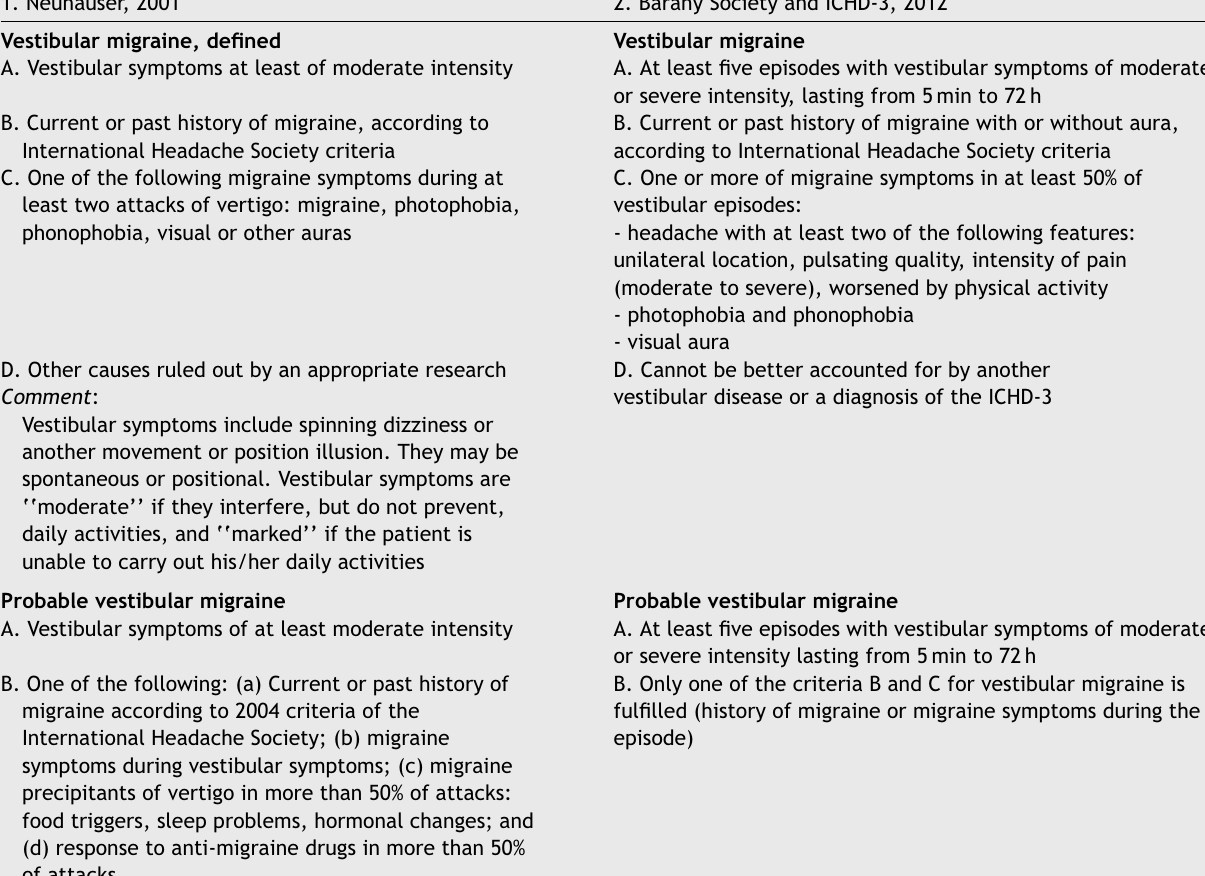
Diagnostic criteria for vestibular migraine proposed by (1) Neuhauser, 2001 8 and (2) the Bárány Society and the third International Classification of Headache Disorders (ICHD-3), 2012. 3,9